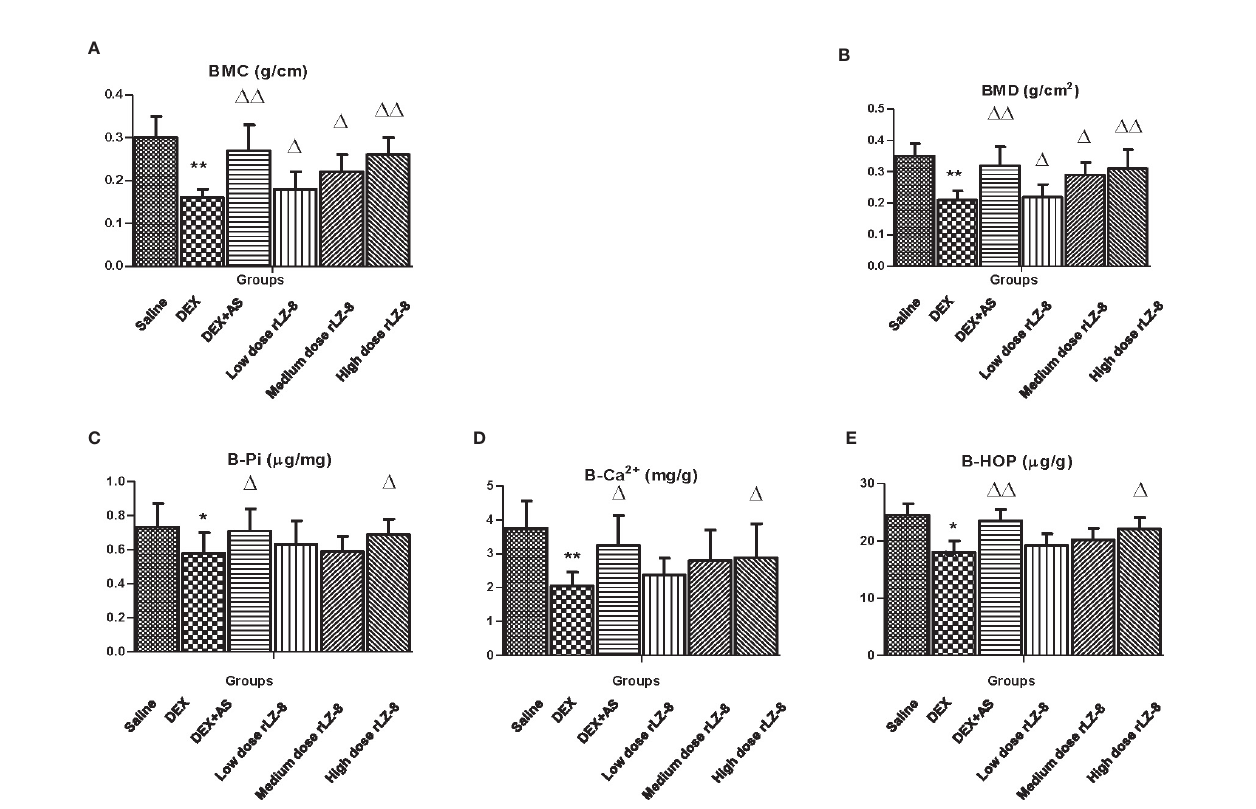
FIGURE 2 | Effects of rLZ-8 on bone density reduction of femur caused by DEX. Bone density of each group was presented as BMC (A) and BMD (B) . BMC in DEX groups decreased signi fi cantly compared to saline groups (** P < 0.01). AS and different dose of rLZ-8 co-treatment with DEX increased the BMC compared to the DEX group. BMD has the same trend as BMC. Each groups use fi ve independent slices. Concentration of phosphorus (C) , calcium (D) and hydroxyproline (E) in femurs were measured in each group. * P < 0.05 versus saline group; ** P < 0.01 versus saline group; △ P < 0.05 versus DEX group; △△ P < 0.01 versus DEX